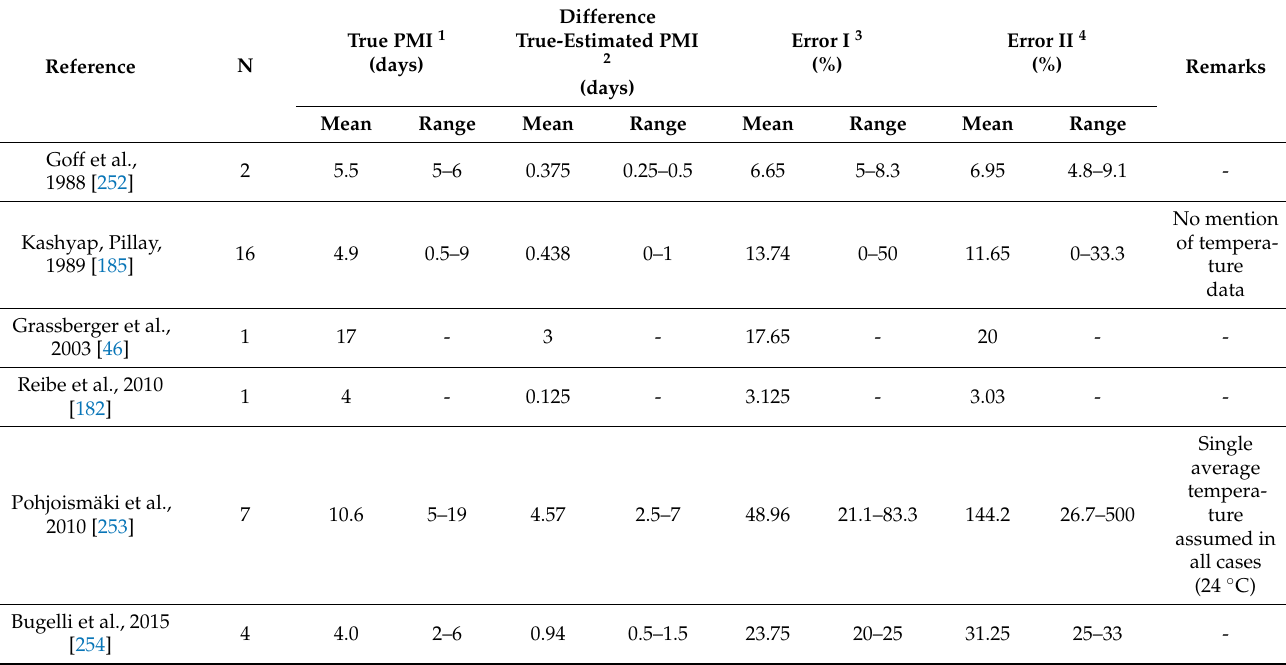
Figure 2. Differences between the true and estimated PMI plotted against the true PMI for the estimations based on insect development that were referenced in Table 5. Table 5. Errors of the protocols for the estimation of PMI based on insect